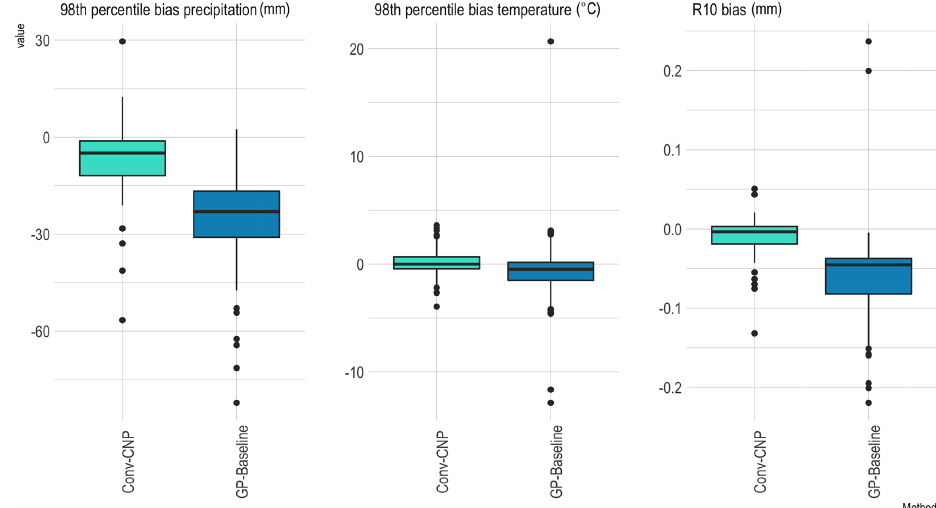
Figure 8. The same as for Fig. 6 but for P98 and R10